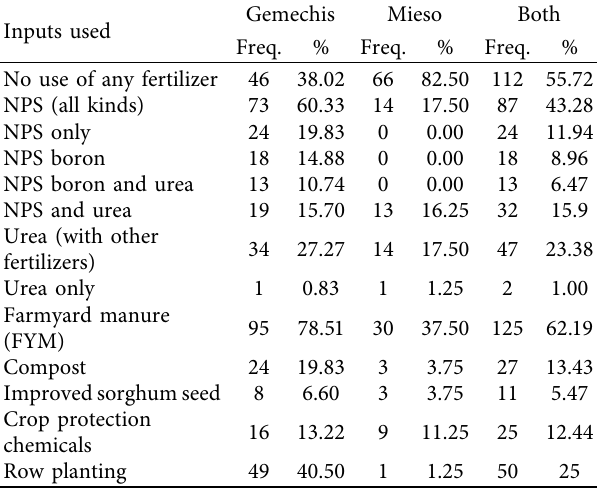
Table 3: Farmers adopted inorganic and organic fertilizers and other inputs in the 2017/18 production